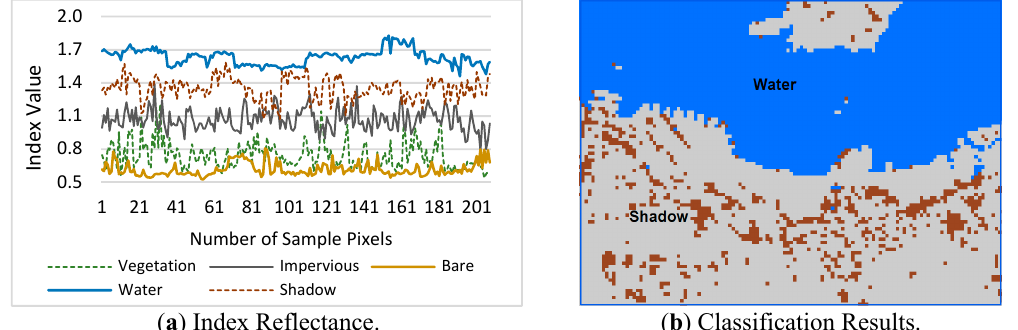
( a ) Index Reflectance. ( b ) Classification Results. Figure 15. Water and shadow detection using the ShDI in Hong Figure 15. Water and shadow detection using the ShDI in Hong Kong.